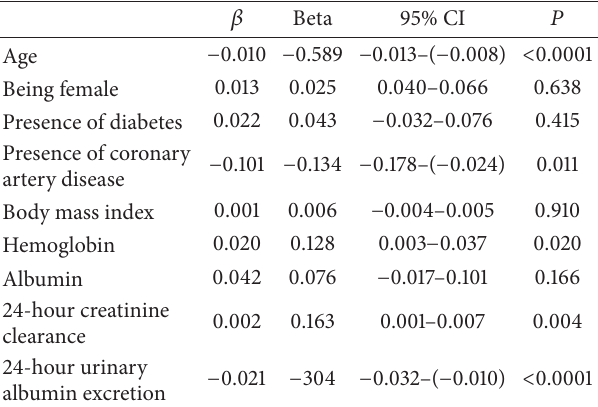
Table 4: Results of linear regression of independent factors core- lated with Nottingham Extended Activities of Daily Living Scale